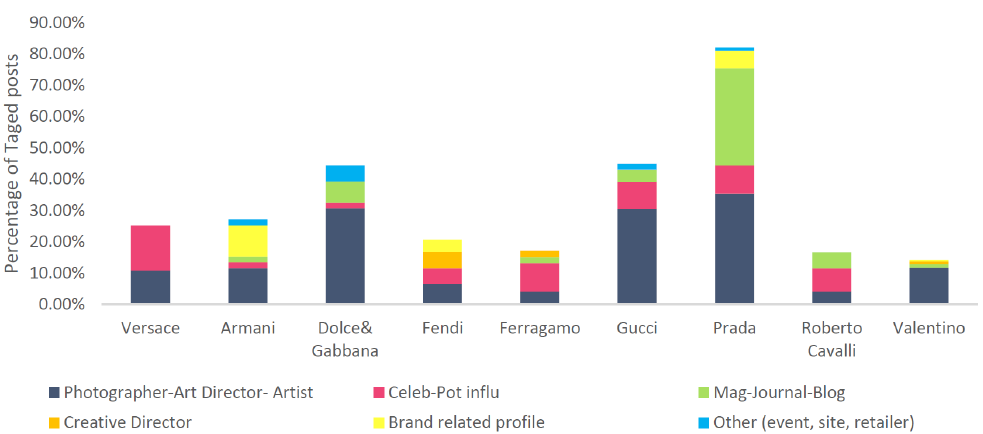
Figure 9. Share of top 10 mentioned profiles in 6 categories by